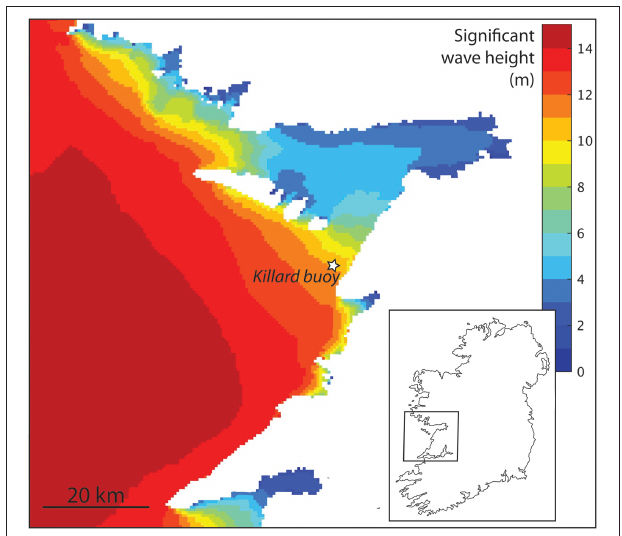
FIGURE 5 | WAVEWATCH III model outputs showing H s from the peak of the February 1, 2014, storm, which generated the largest seas of winter 2013-2014. From Janji ´ c